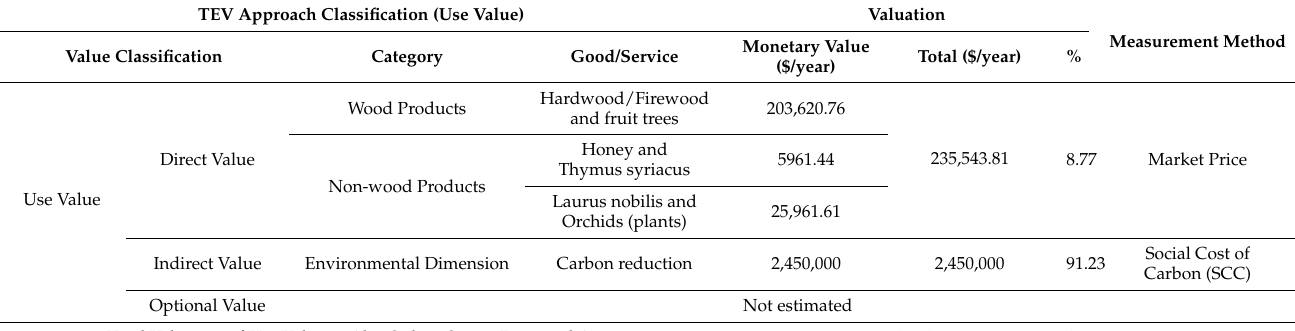
Table 1. Monetary values of ecosystem use value in Abu Qubies protected area.